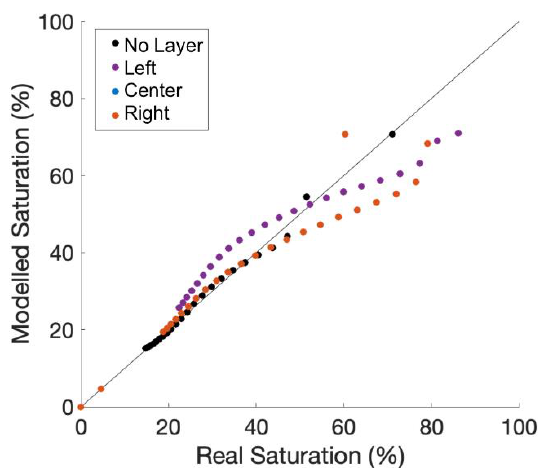
Figure 9. The simulation results of a 0.01 m thick low permeability layer with a small gap to the left, right and directly above the cable. Note, the observation node remains to the left of the cable.